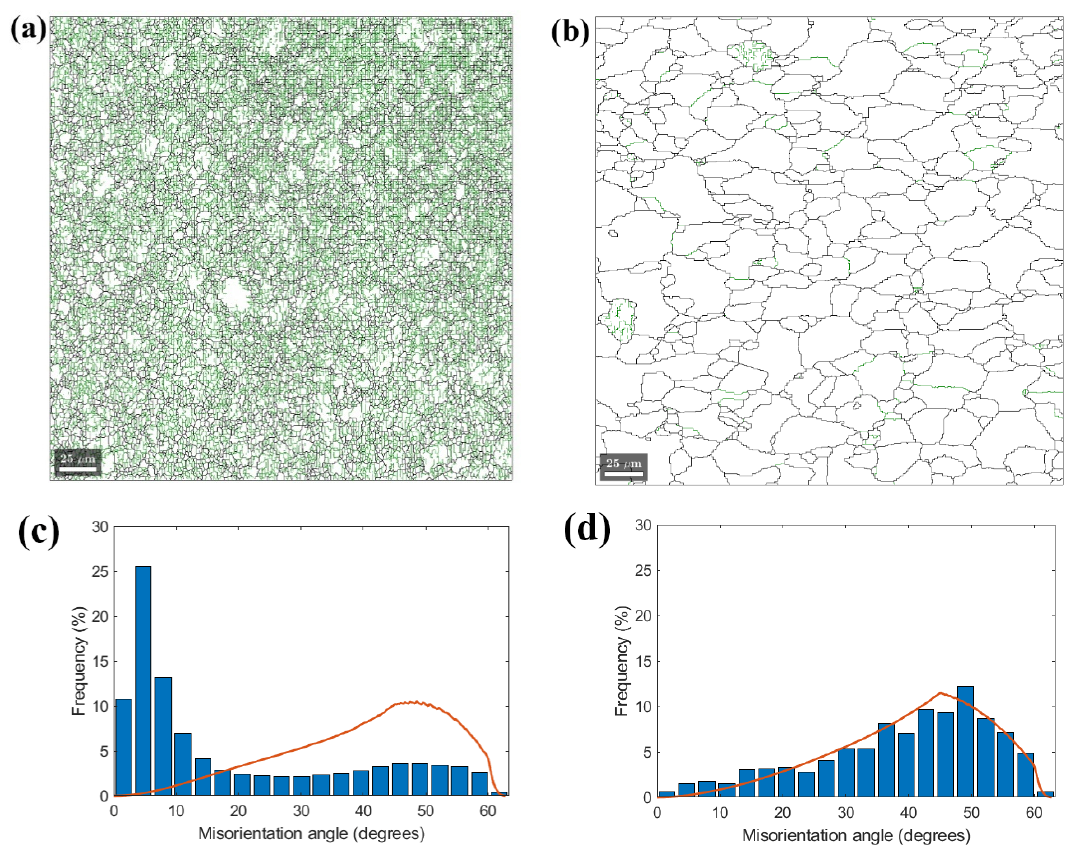
Figure 2. Grain boundary maps (top) and orientation distribution maps (bottom) of the TD–ND surface of the rolled sample ( a , c ) and fully recrystallized sample ( b , d ).